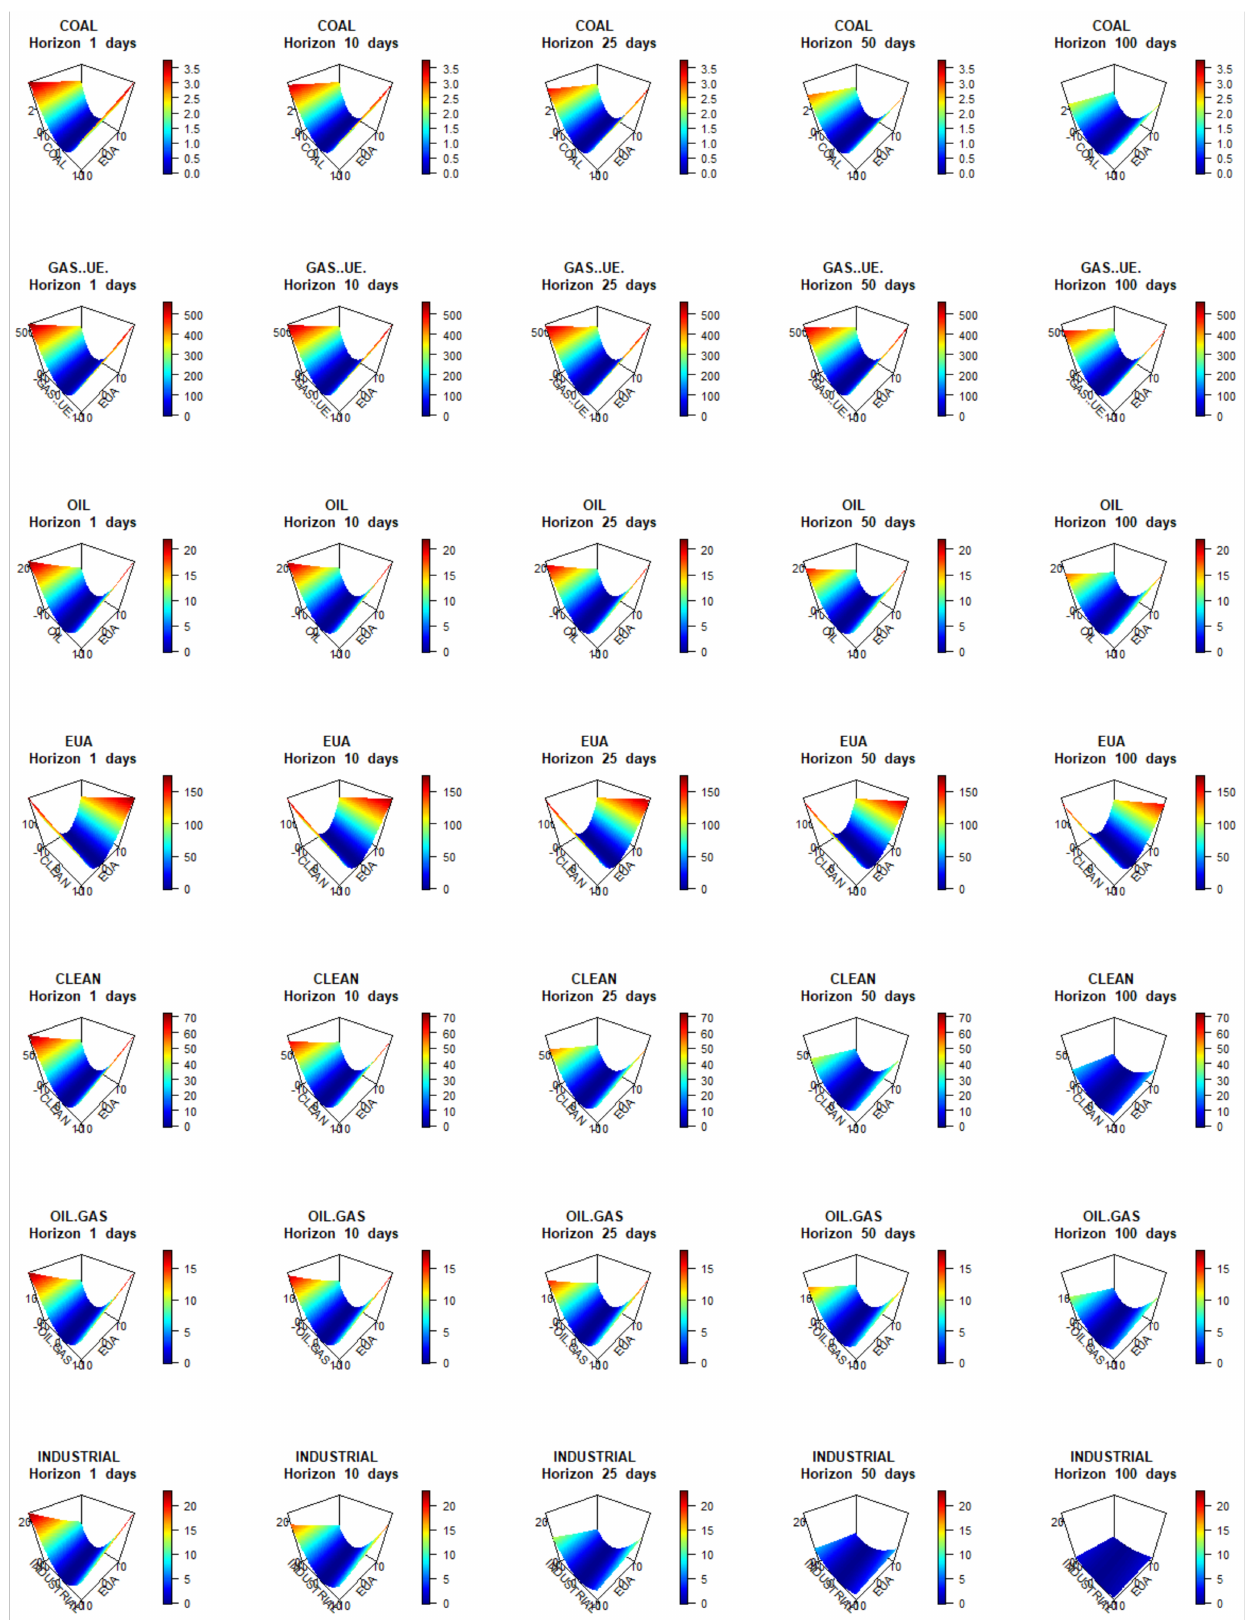
Figure 13. Matrix graph with the dynamic evolution of response surfaces of the conditional volatility of each variable to bivariate impulses in all pairs of combinations of each variable with EUA. Each row corresponds to the response of each variable and each column to a temporal